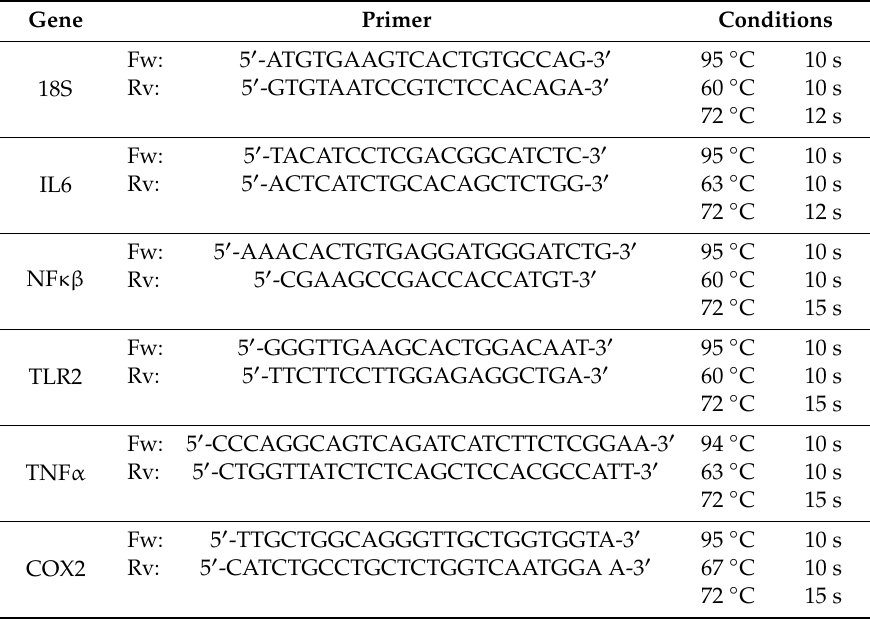
Table 1. Primer sequences and conditions used in real-time